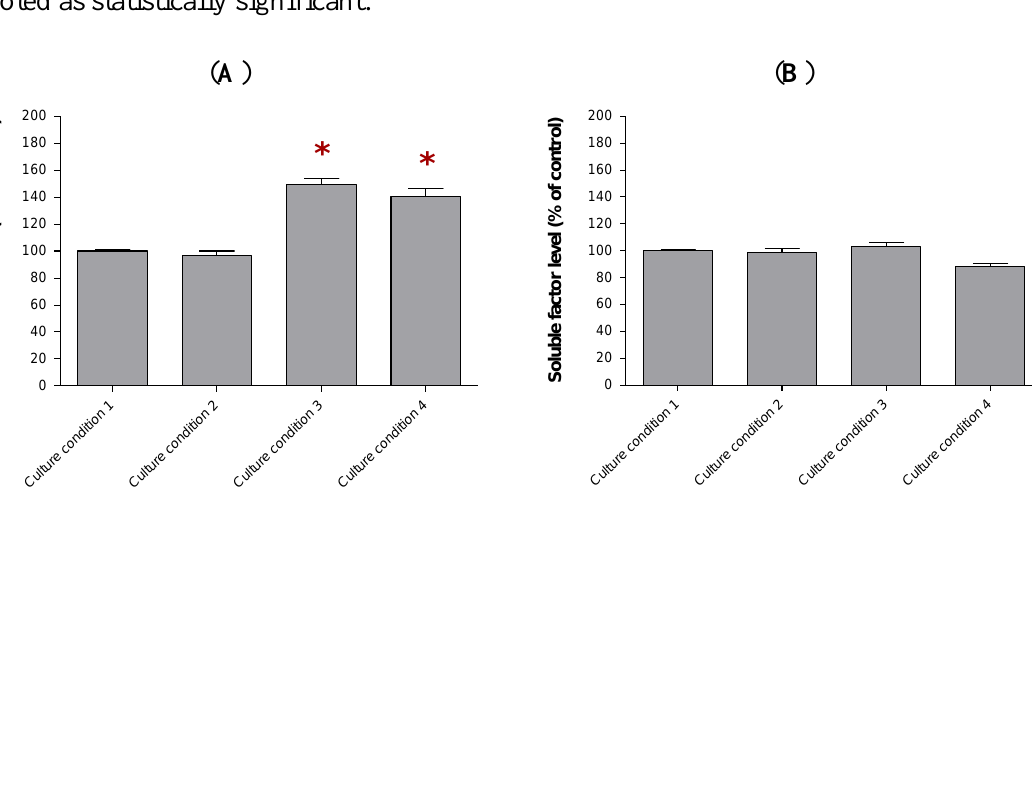
Figure 8. The expression levels of ( A ) soluble factor a , ( B ) soluble factor b , ( C ) soluble factor c , and ( D ) soluble factor d in the conditioned media of MCF-10A cells preincubated with pioglitazone and/or serum-rich growth media. The levels of the soluble factors were assayed by ELISA. The levels of soluble factors in the conditioned medium of MCF-10A cells preincubated with Culture Condition 1 was defined as 100%. The values were expressed as mean ± SD from 3 replicates. * p < 0.05, ** p < 0.01 and ** p < 0.001 were denoted as statistically